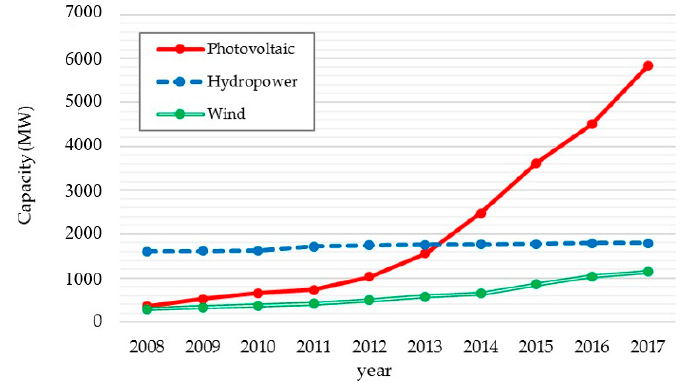
Figure 1. Installed capacity of renewable energy sources in Korea (from kosis.kr).